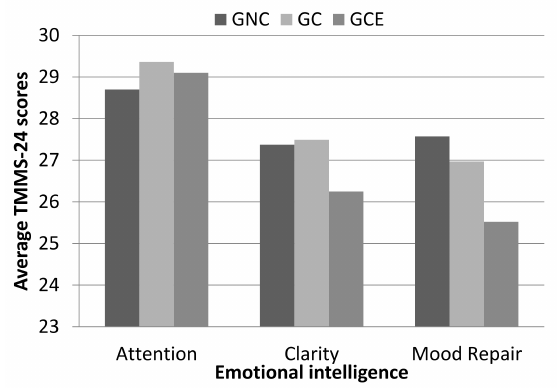
Figure 1. Average of the dimensions of emotional intelligence (TMMS-24) by groups. Note: GNC = Group of non-consumers; GCE = Group of occasional consumers; GC = Group of